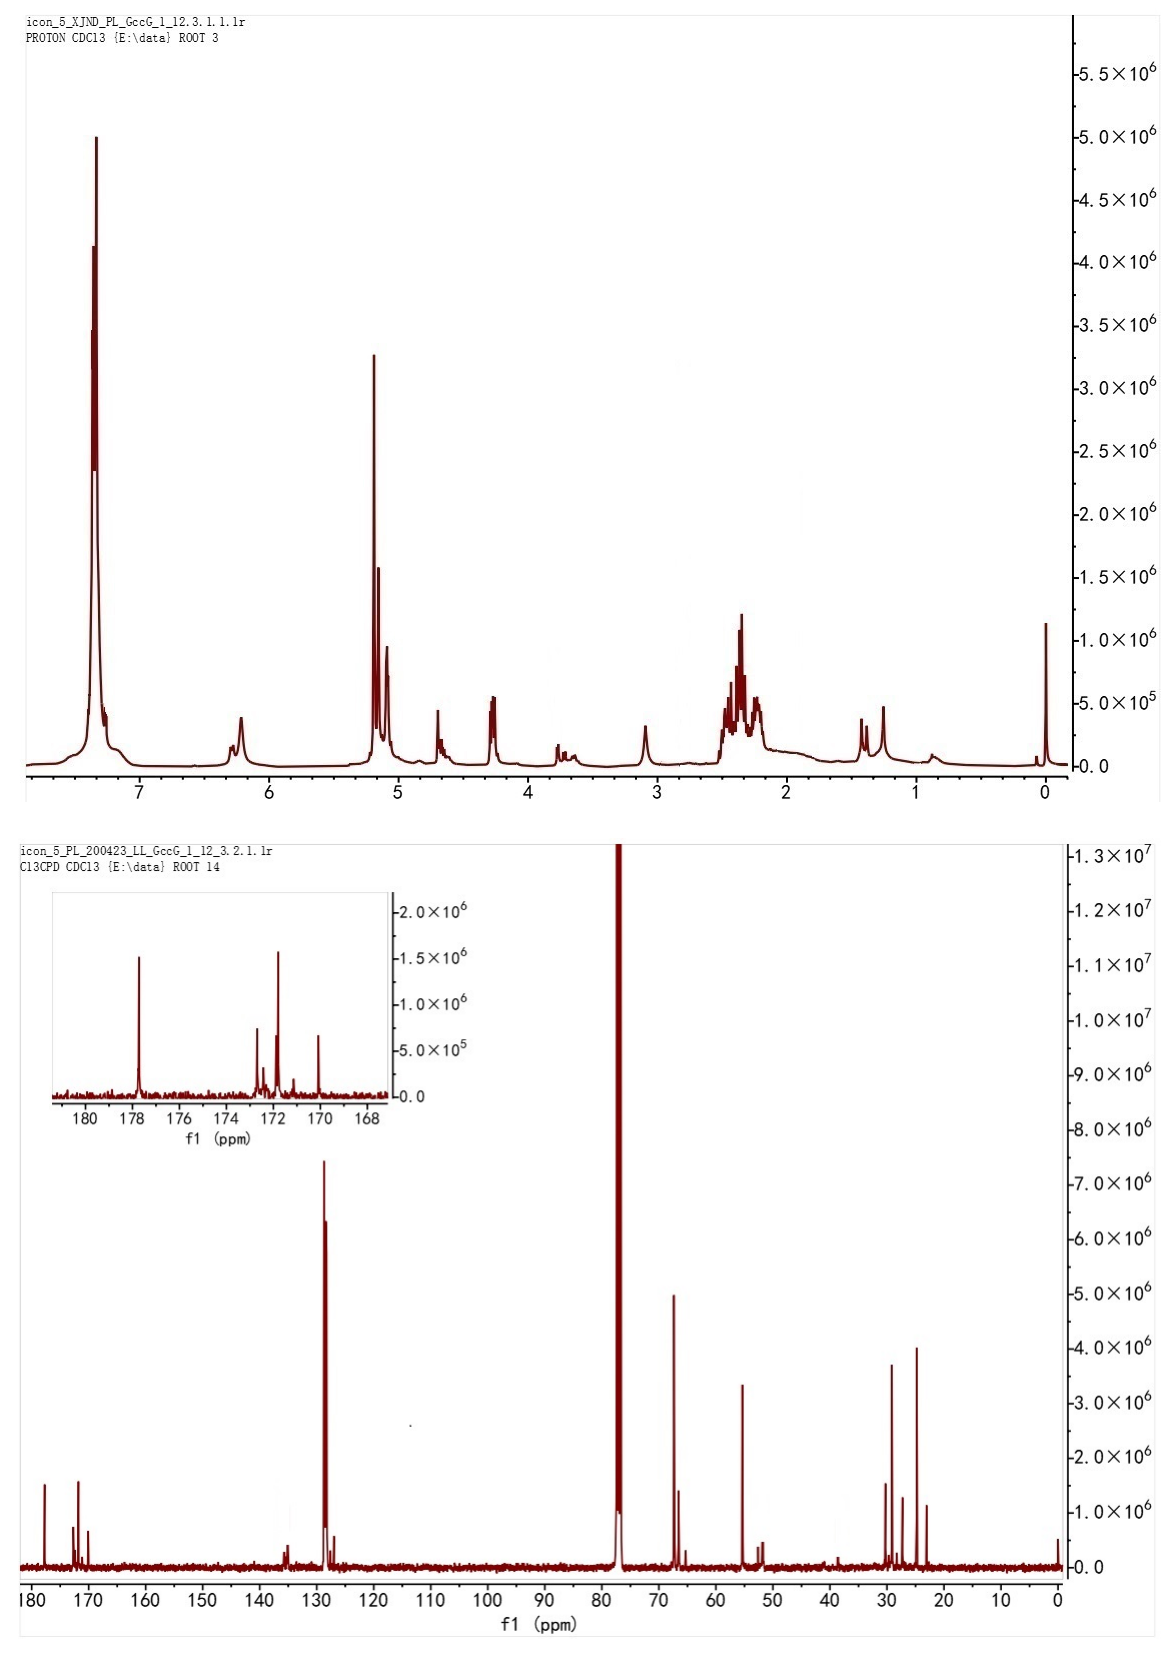
Figure 1. The 1 H NMR and 13 C NMR of dendrimer GCCG.